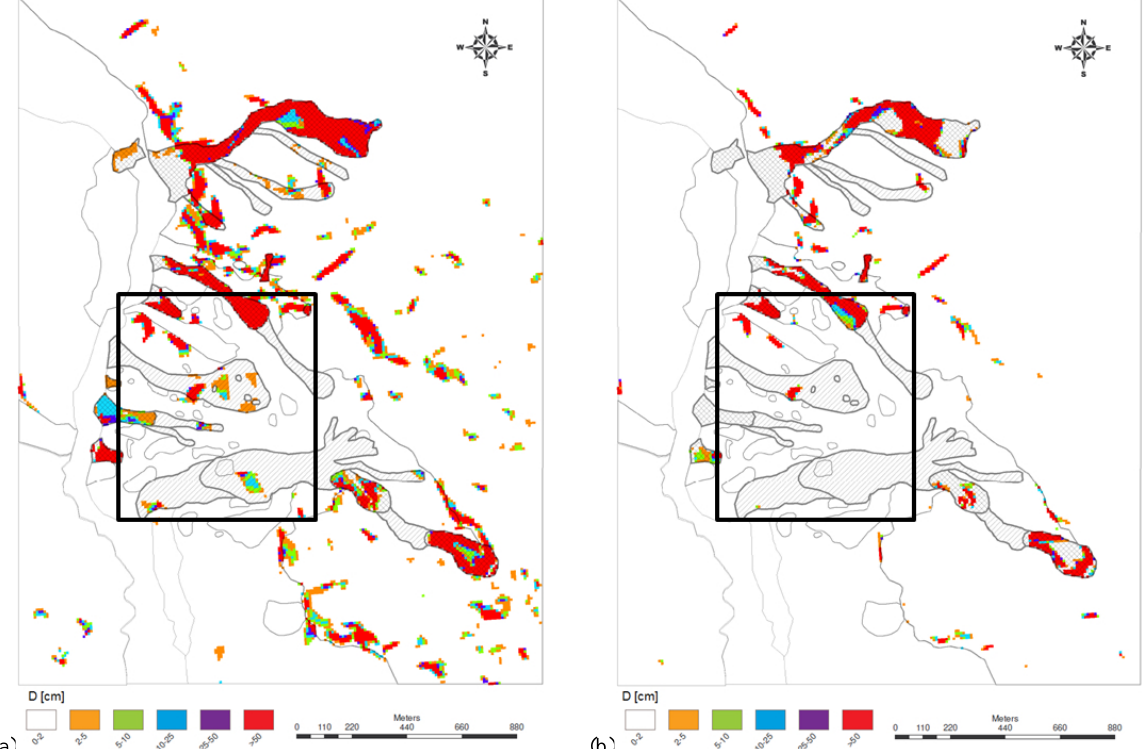
Fig. 7. Permanent displacements calculated by means of the equations by (a) Ambraseys and Menu modified by Jibson (2007), and by (b) Jibson (2007). The dark rectangle approximately indicates the urban